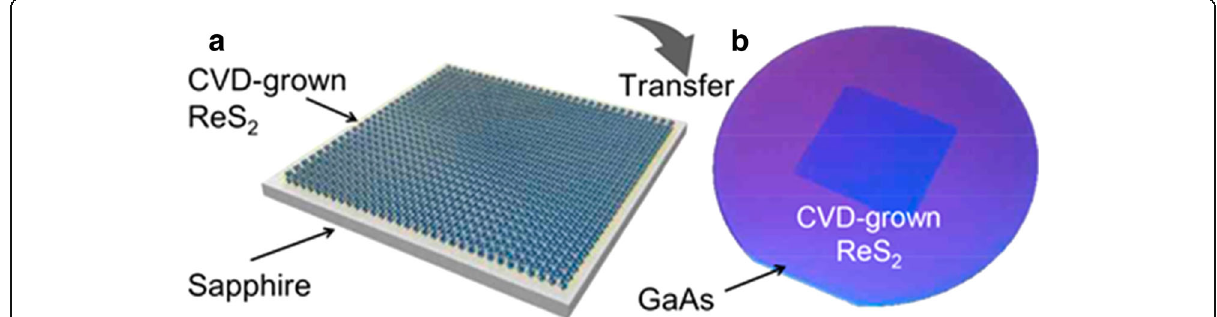
Fig. 1 a , b The fabrication procedure of the ReS 2 /GaAs